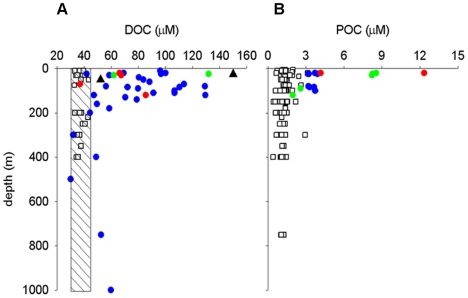
Depth distribution of organic matter pools during summer and winter cruises.Summer 2004: blue circles = ACC water; red circles = shelf water; green circles = mixed water; empty square = Winter 2006. (Panel A) DOC = Dissolved organic carbon. The data presented are measurements of total organic carbon, but since POC represents a negligible contribution to total organic carbon (POC represented only between 7% and 2% of the total pool) we can consider the analysis as DOC values. The shaded area covers the range of winter concentration. For a comparison, a range of variations of DOC from the FRUELA cruise study area in summer (Gerlache Strait, Bransfield Strait and Bellinghausen Strait) [22] has been reported (black triangles). (Panel B) POC = Particulate organic carbon.